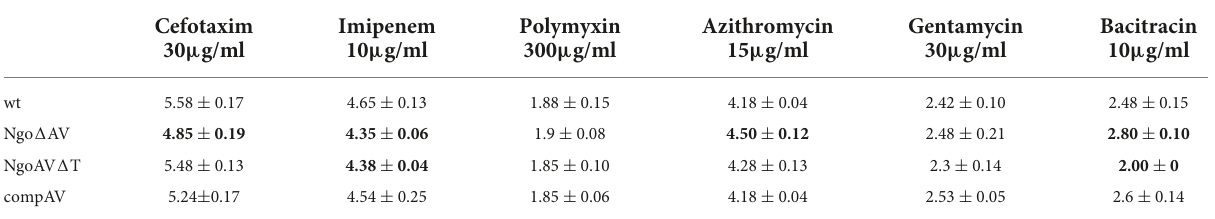
TABLE 2 Susceptibility of N. gonorrhoeae mutants within NgoAV RM system to